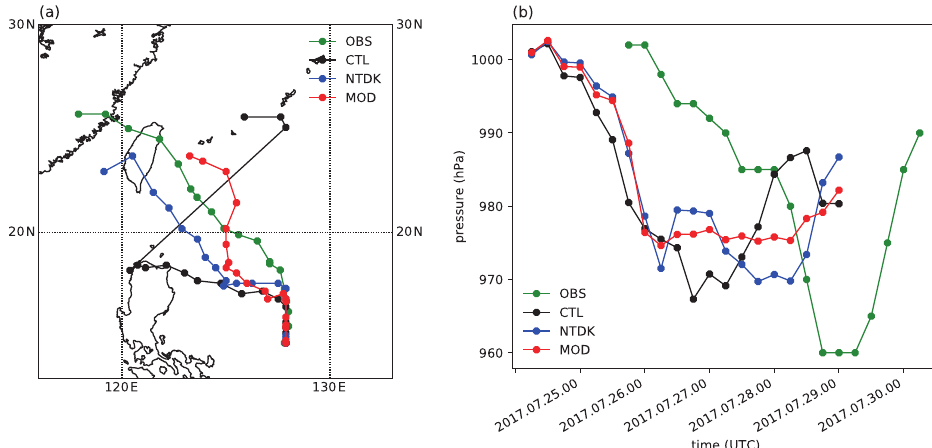
Figure 7. ( a ) Trajectories of the TC Nesat and ( b ) time series of the minimum sea-level pressure from KMA (green) and CTL (black), NTDK (blue), and MOD (red)